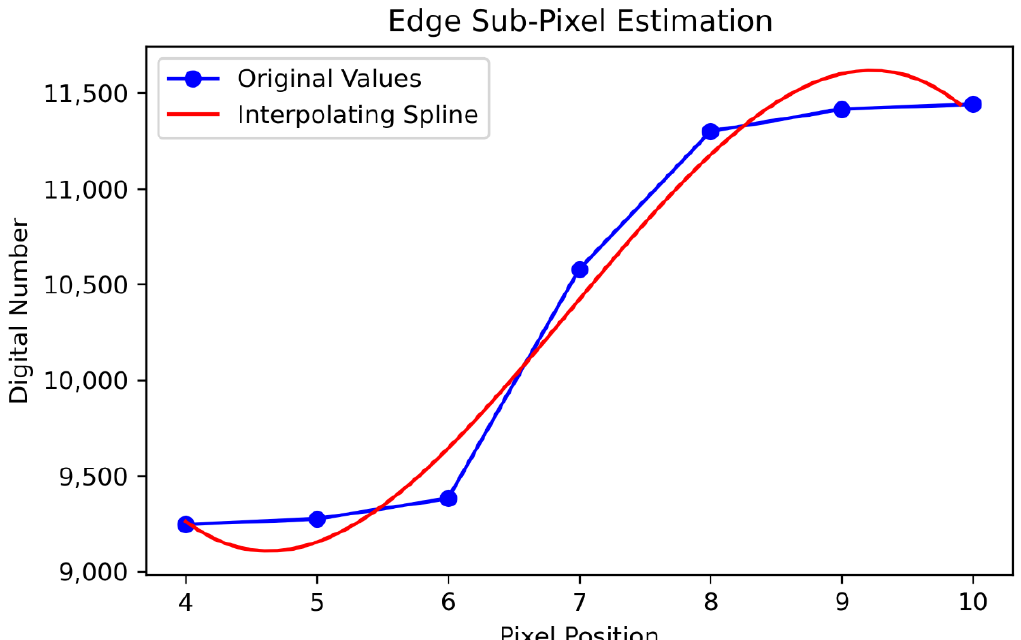
Figure 3. Example of sub-pixel location estimation for a single edge: original DN values (blue line) and cubic spline fit (red line).